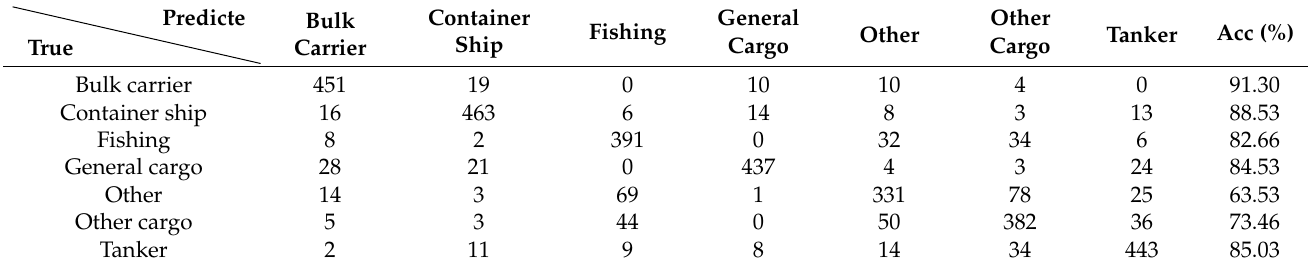
Table 9. Classification confusion matrix of ResNet on the FUSAR-Ship